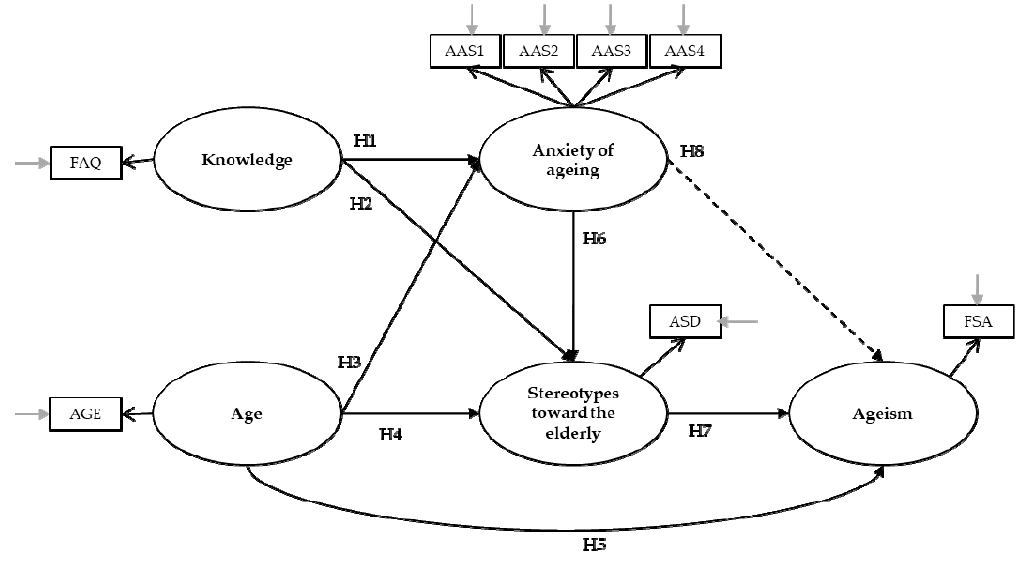
Figure 1. Conceptual model.